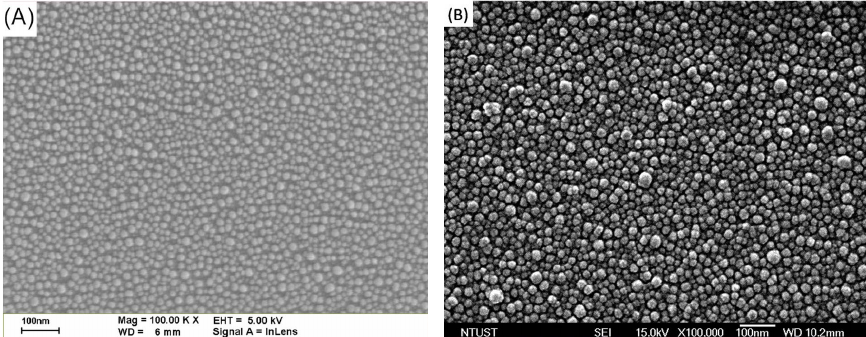
Figure 3. SEM images showing the size and profile of metallic nanoparticles: ( A ) In-NPs; ( B ) Ag-NPs.